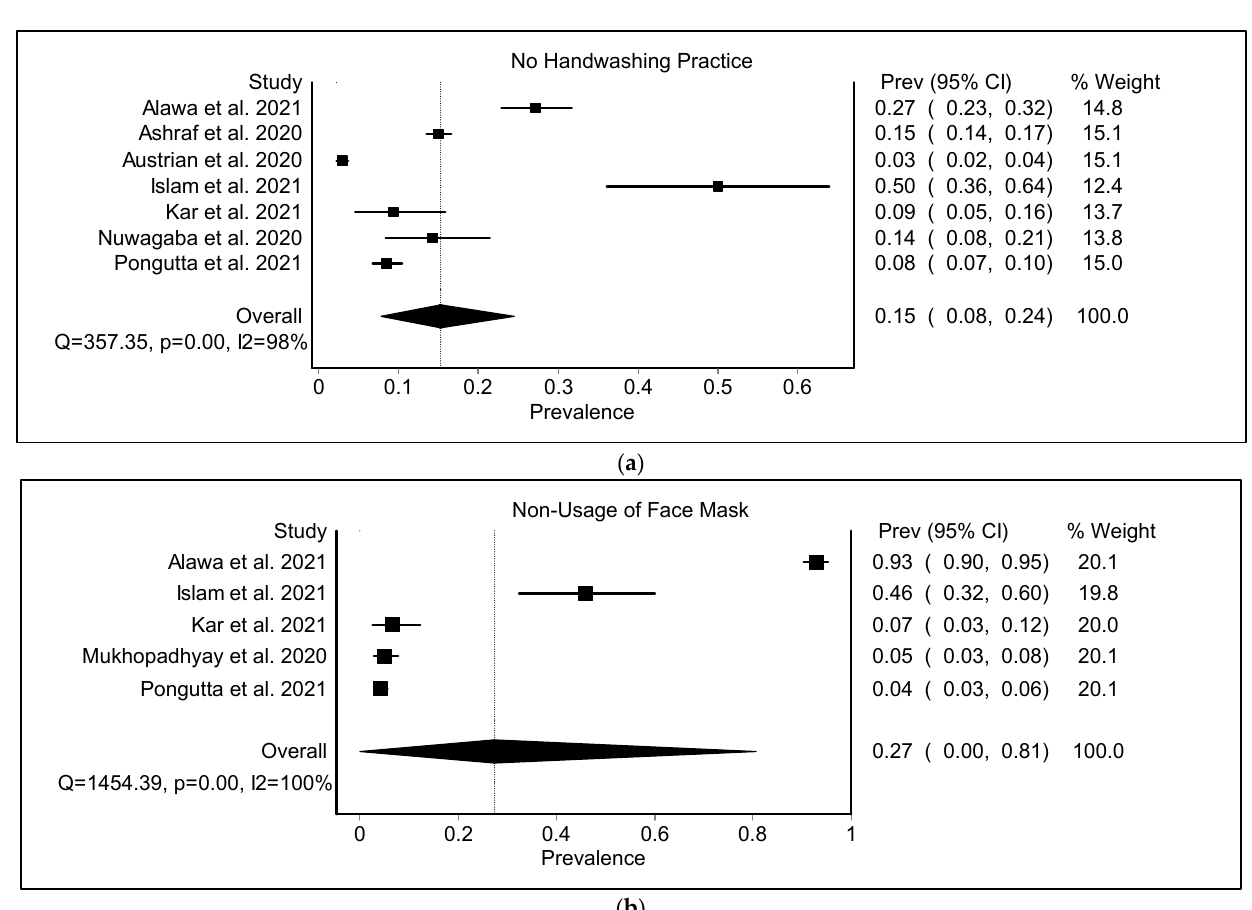
Figure 3. ( a ) The pooled prevalence of non-adherence to hygiene practices among the urban poor during the COVID-19 pandemic. ( b ) Pooled prevalence of non-adherence to face masks as a measure of hygiene and prevention among urban poor during the COVID-19 pandemic [25,46,48,49,52,53,55,56]. I cannot imagine how residents would practice physical distancing and hygiene in